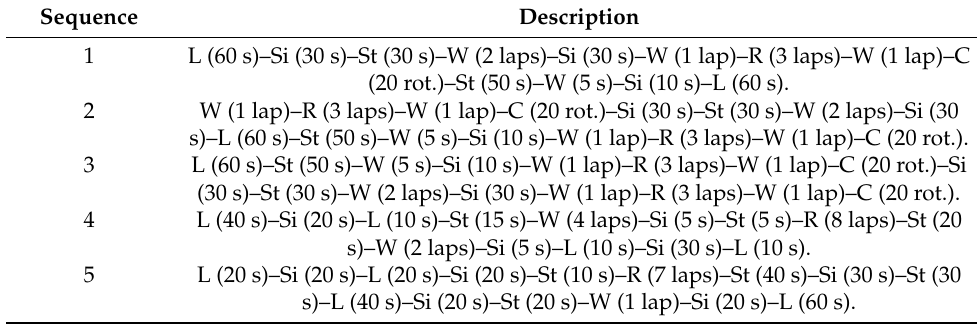
Table 2. Description of the performed sequences. Abbreviations: L = Lie, Si = Sit, St = Stand, W = Walk, R = Run, C = Cycle. The first sequence was performed twice, all other sequences once.